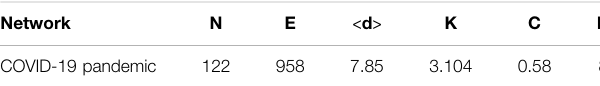
Table 1 presents the topological information of the COVID-19 pandemic network. N is the number of nodes. E is the number of edges. < d > is the average degree of the whole network. K represents the average path length of the network. C is the clustering coef fi cient of the network. D is the diameter of the